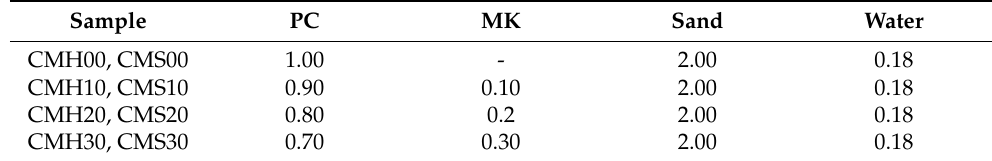
Table 2. Mixed proportion for mortar kg/m 3 . Sample PC Sand Water